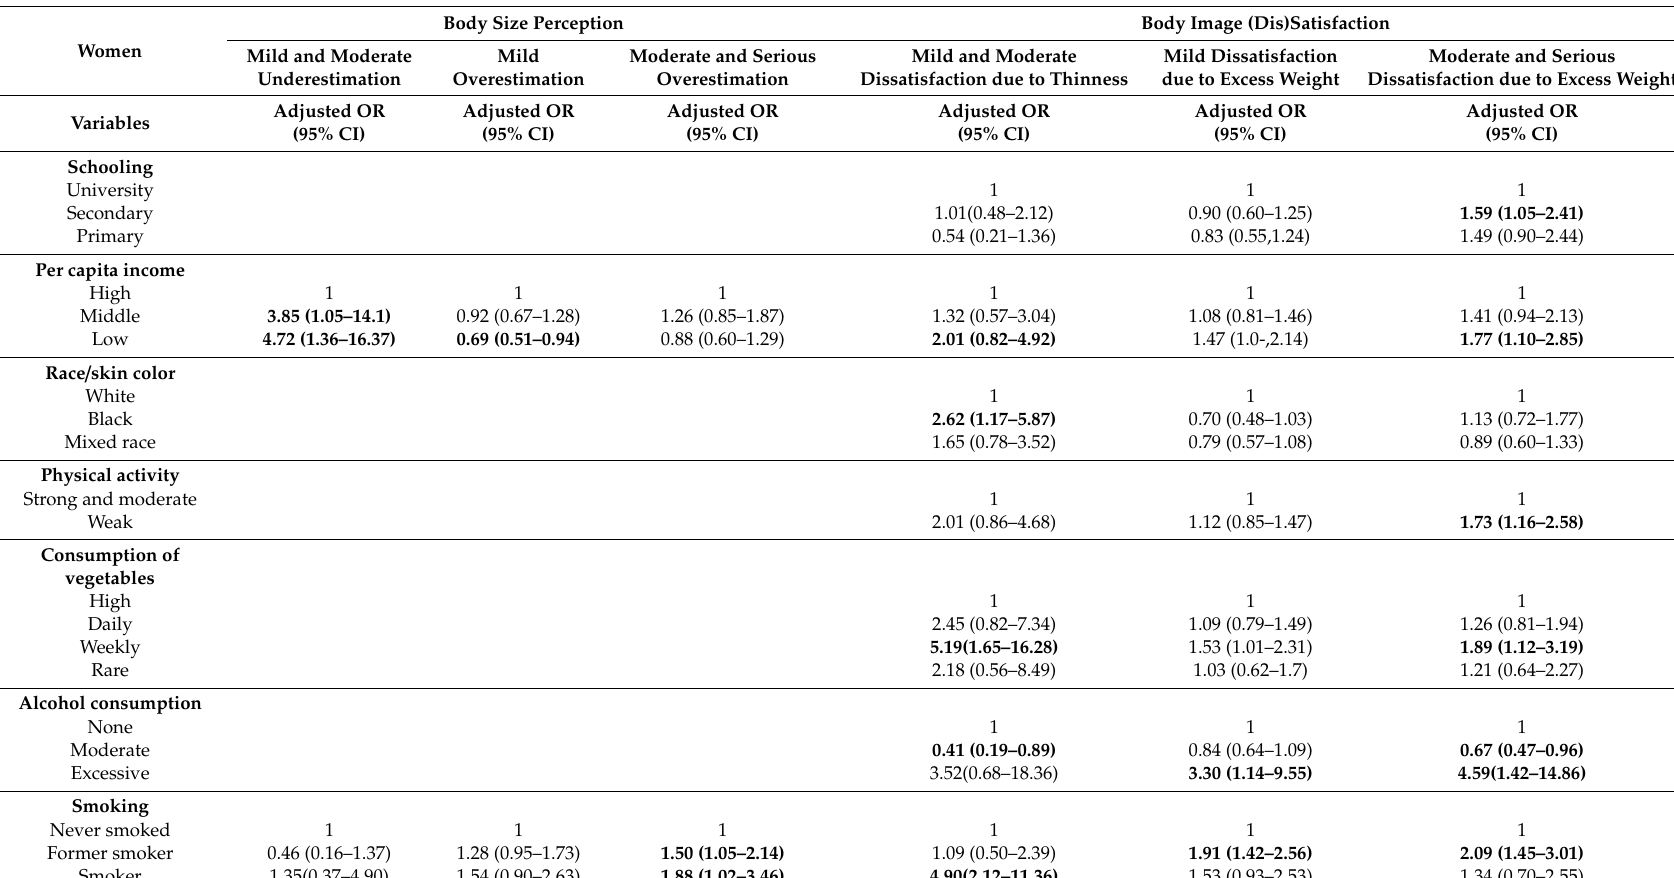
Table 5. Final model for association between body size perception and body image (dis)satisfaction and sociodemographic and behavior factors in elderly women participating in the ELSA-Brasil study